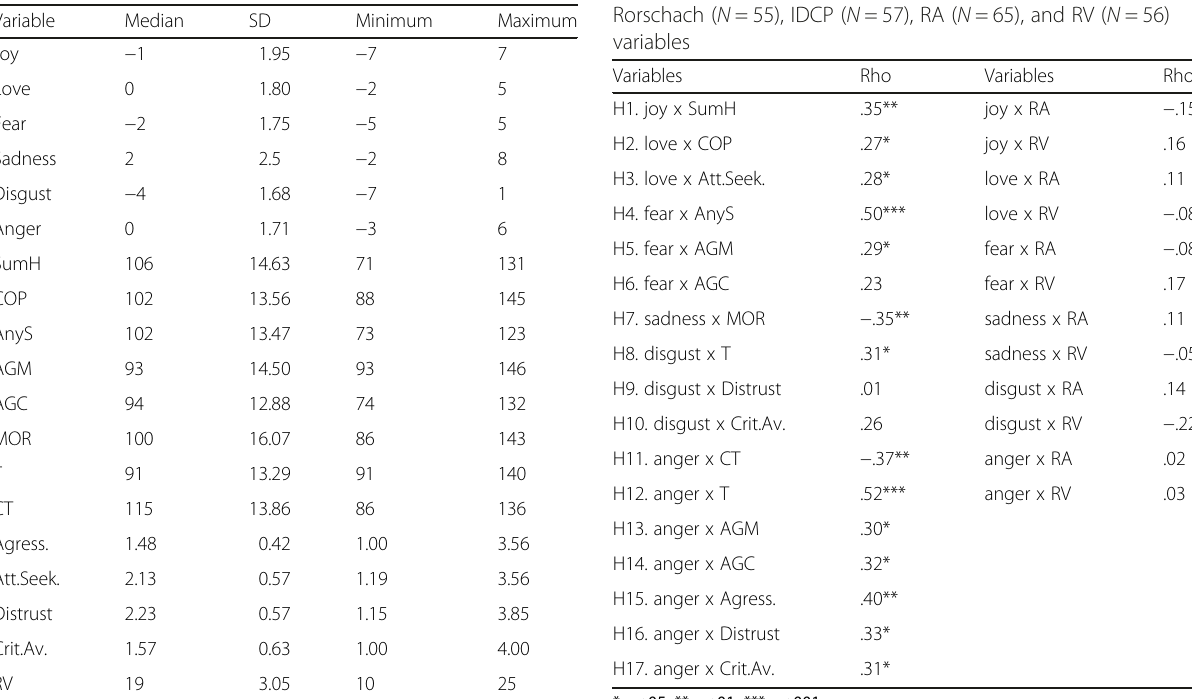
Table 2 Spearman correlations between PEP distortions and Table 1 Descriptive statistics of the